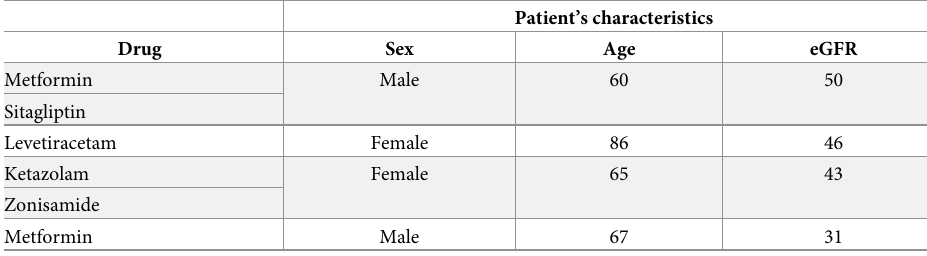
eGFR = Glomerular Filtration.